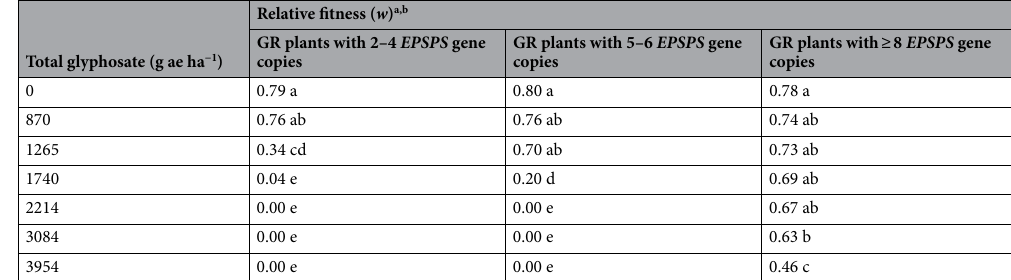
Table 4. Relative fitness (w) of glyphosate-resistant (GR) Bassia scoparia plants (2–4, 5–6, ≥ 8 EPSPS gene copies) in the absence and presence of glyphosate (total rate ≥ 870 g ae ha -1 applied as single or sequential applications) in a field study conducted over two years at the Montana State University Southern Agricultural Research Center near Huntley, MT, USA. a Relative fitness was calculated as the reproductive rate (seeds plant −1 ) of the resistant genotype relative to the maximum reproductive rate of the susceptible genotype in the population. The relative fitness ( w ) of the susceptible plants was 1.0. b Means followed by the same letter are not different based on Tukey–Kramer’s HSD α(0.05) = 0.135 .